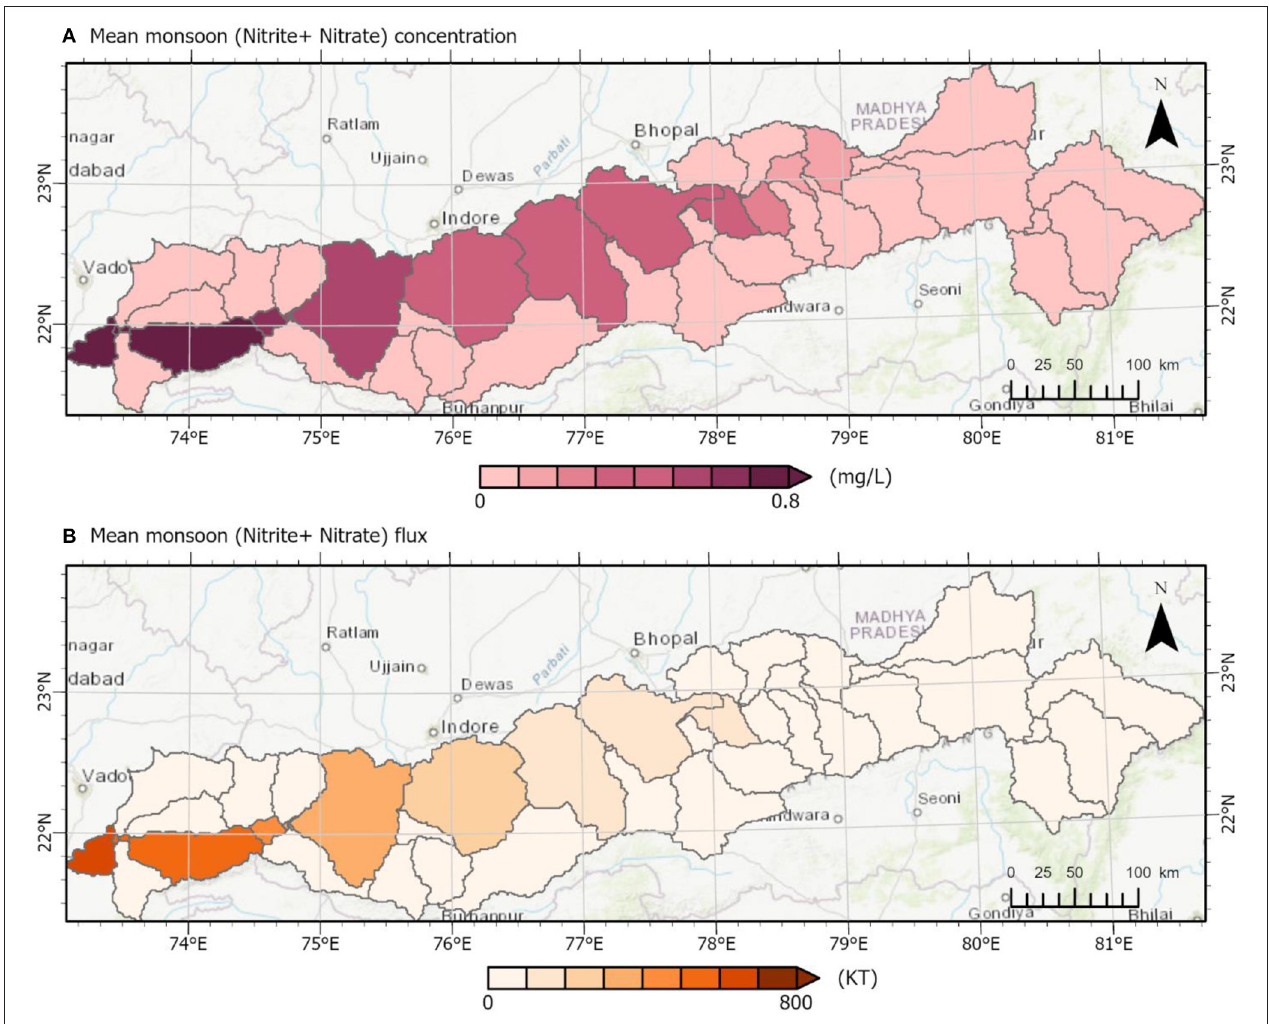
FIGURE 8 | (A,B) : (A) Mean monsoonal (NO 2 + NO 3 ) concentration spatial variation across the subbasins in the Narmada River basin. (B) Mean monsoonal (NO 2 + NO 3 ) flux spatial variation across the subbasins in the Narmada River basin. The flux values are in the order Kilo Tons (KT). Monsoonal concentration was obtained by taking mean of concentration values for individual months from June to September. Monsoonal flux was obtained by summation of flux values for individual months from June to